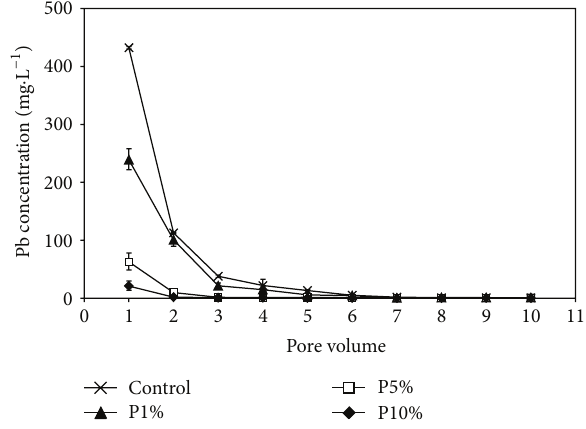
Figure 3: Pb concentration in the leachate from Pb-contaminated soils amended with peat moss through the column leaching exper- iment (control: Pb-contaminated soil without peat moss, P1%: Pb- contaminated soil with 1% peat moss, P5%: Pb-contaminated soil with 5% peat moss, and P10%: Pb-contaminated soil with 10% peat